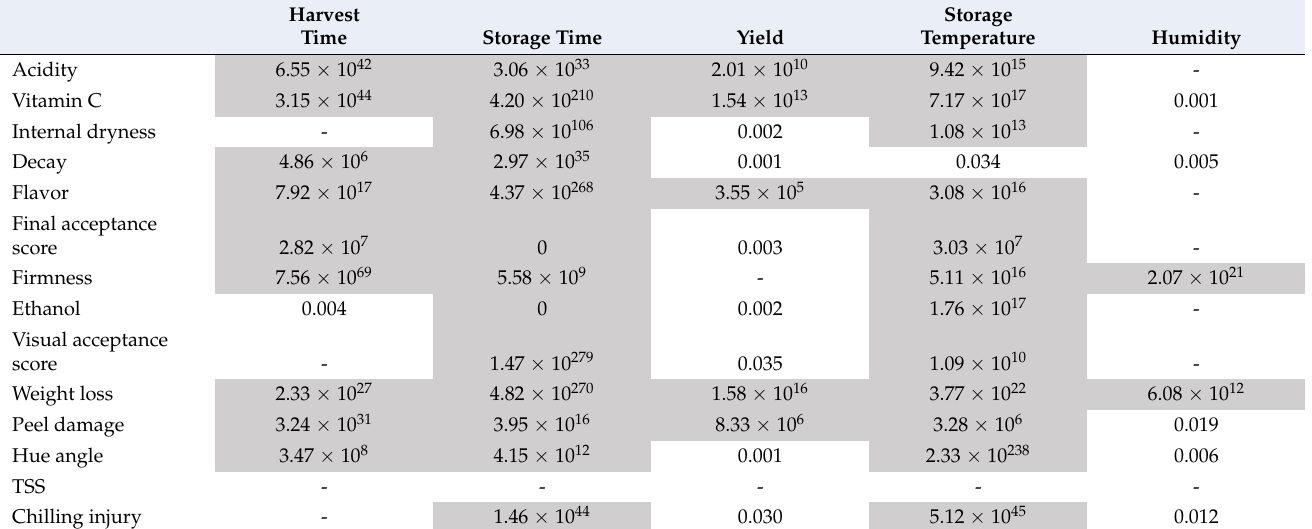
Table 2. Effects of different pre-harvest and postharvest features on the quality attributes of ‘Rusten- burg’ navel oranges. The presented data are ANOVA p values. Gray shading indicates statistical significance ( p ≤ 0.001).